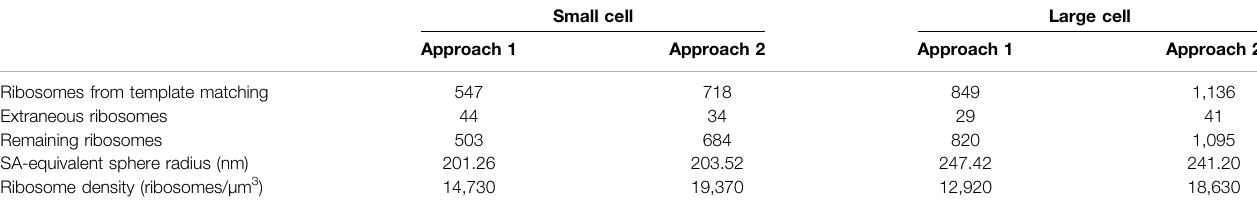
TABLE 1 | Summary of the ribosome distributions and cell geometries resulting from the two template matching methods for both the small and the large